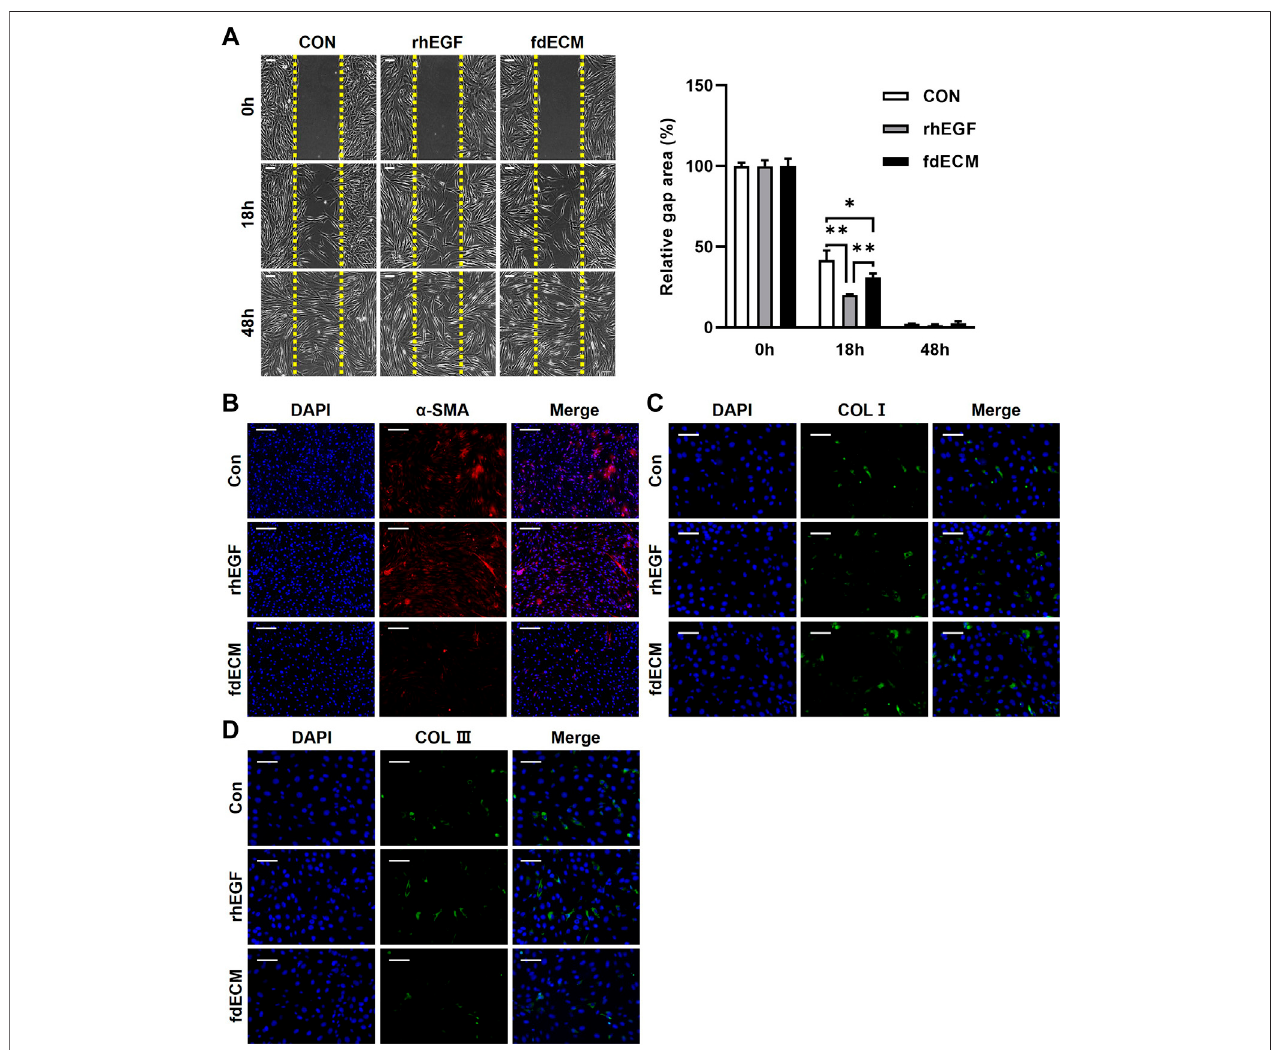
FIGURE 5 | Phenotype change of human dermal fi broblasts after fdECM treatment. (A) Representative images of scratch wound healing assay using human dermal fi broblasts and semi-quantitative analysis of relative scratch area calculated as ratio for original defect area. Yellow dashed line indicates the original site of the scratchwound. (B – D) Immuno fl uorescenceimagesof α -SMA (B) ,COLI (C) ,andCOLIII (D) expressionafter48 hoffdECMtreatment.Scalebarsrepresent200 μ m (B) and 100 μ m (A,C,D) . Results are expressed as mean ± standard deviation (SD). * p < 0.05, ** p <